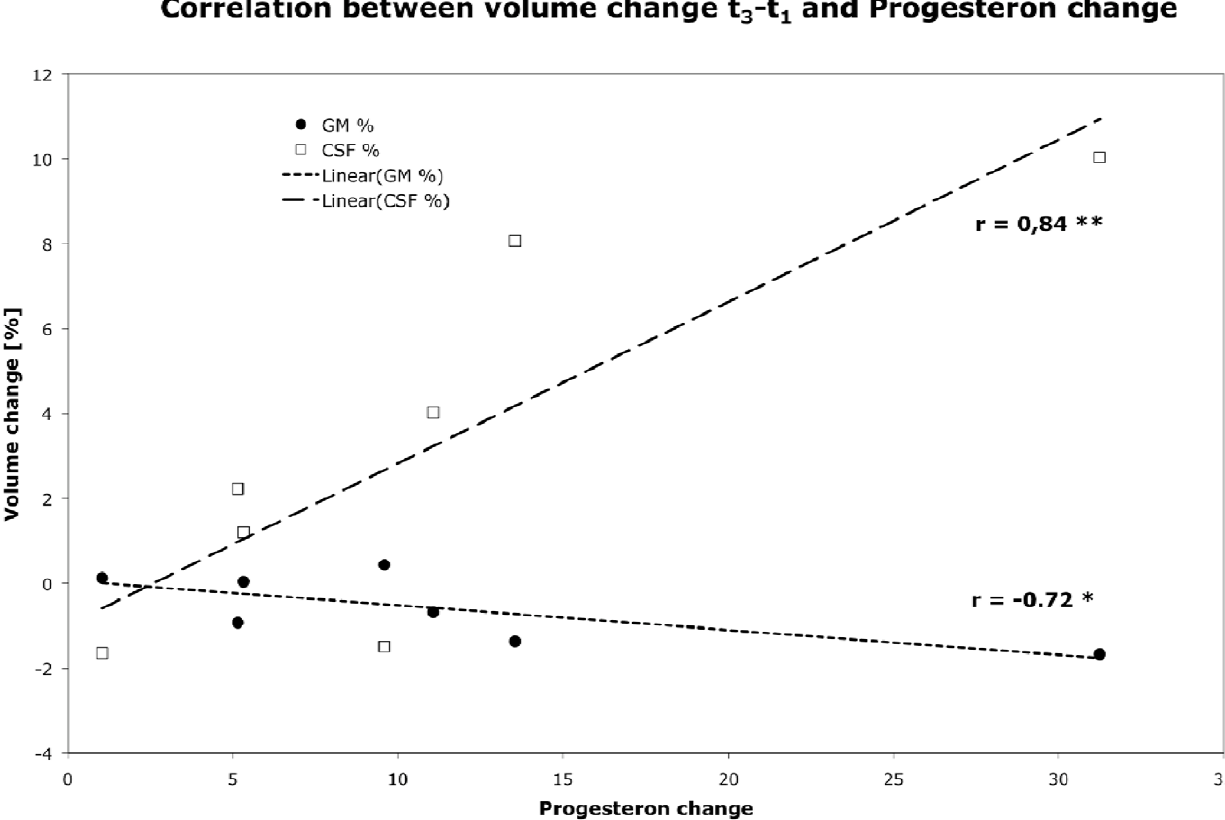
Figure 3. Correlation between the (not significant) relative volume change of grey matter and CSF in females between t3 and t1 and progesterone levels at the appropriate time points.